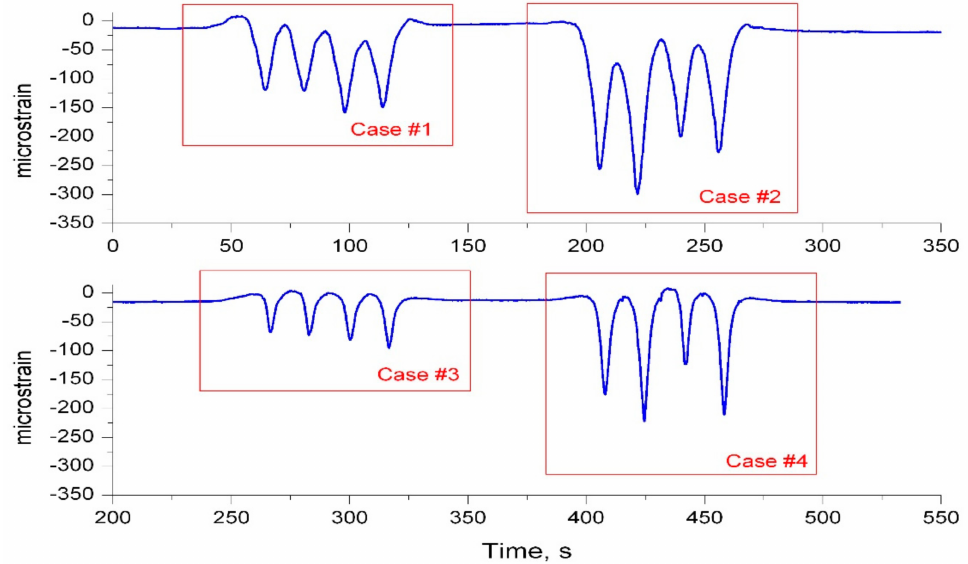
Figure 13. Cases #1 to #4 of non-uniform strain distribution in the ring girder of a tested bucket-wheel excavator. Strain values are given in